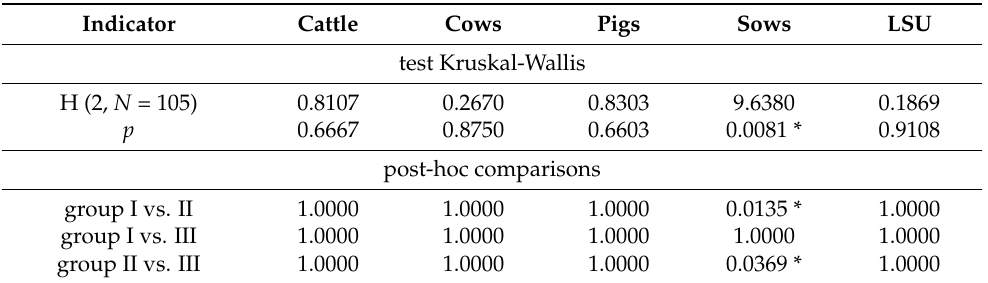
Table 5. The results of the Kruskal-Wallis multiple comparisons test * performed to analyze the dynamics of the changes in livestock (according to the data from the voivodships).